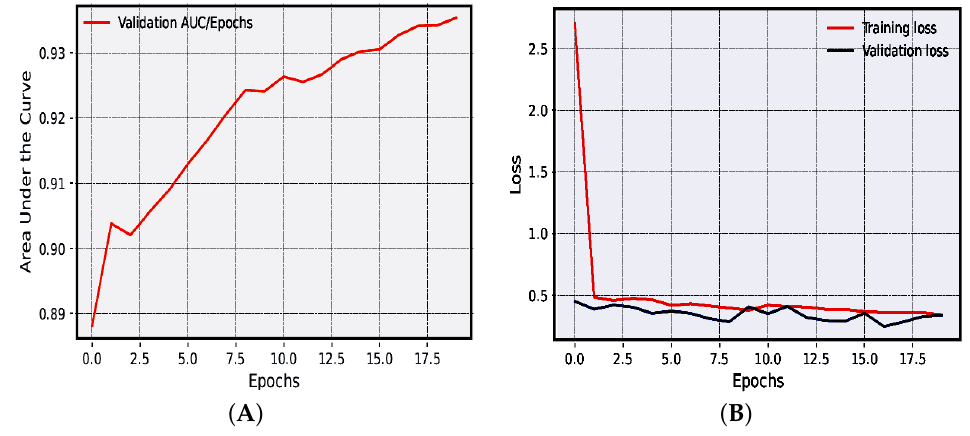
Figure 6. Model performance. ( A ) ROC. ( B ) Training and validation